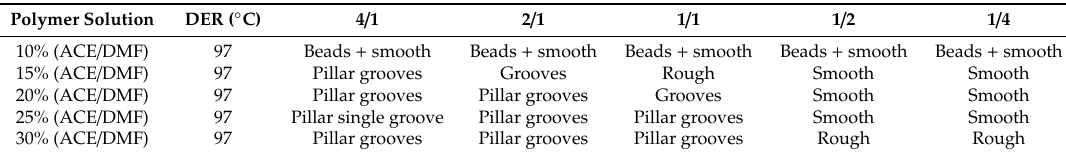
Table 1. Di ff erence in evaporation rate (DER) of acetone (ACE) / N , N -dimethylformamide binary solvent systems and morphologies of PVDF fibers electrospun from this system at di ff erent solvent rations and polymer concentrations. Reprinted with permission from